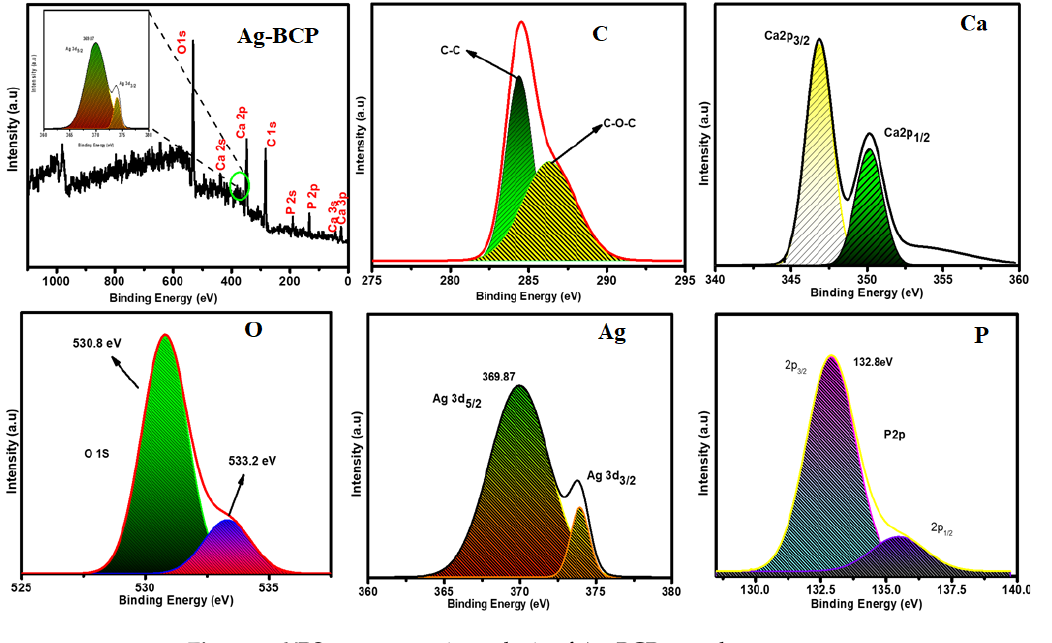
Figure 7. XPS spectroscopic analysis of Ag-BCP samples.